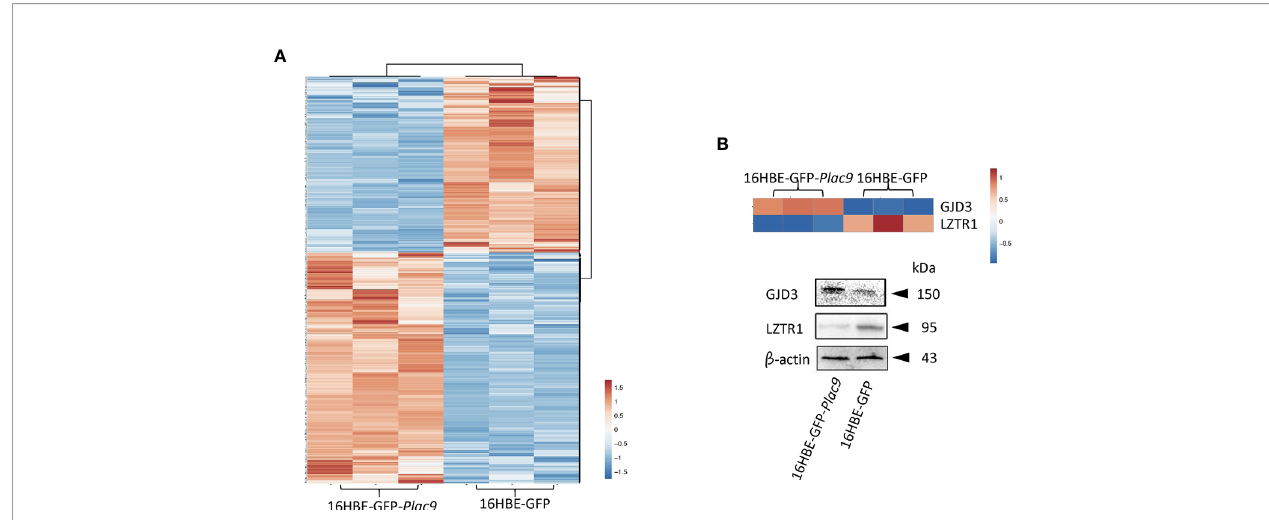
FIGURE 3 | Global identi fi cation of proteins regulated by PLAC9 overexpression. (A) Heatmap of the 714 differentially expressed proteins identi fi ed by iTRAQ in the PLAC9-overexpressing line compared to the control line stably transfected with GFP-expression vector. Three replicates are presented for each cell line. Bar color represents a logarithmic scale from -1.5 to 1.5. (B) Independent validation of two differentially expressed proteins (GJD3 and LZTR1) identi fi ed via iTRAQ using western blot analysis. Total proteins were isolated from the two cell lines (16HBE-GFP- Plac9 and 16HBE-GFP) for western blot analyses with antibodies against GJD3, LZTR1, and the control was b